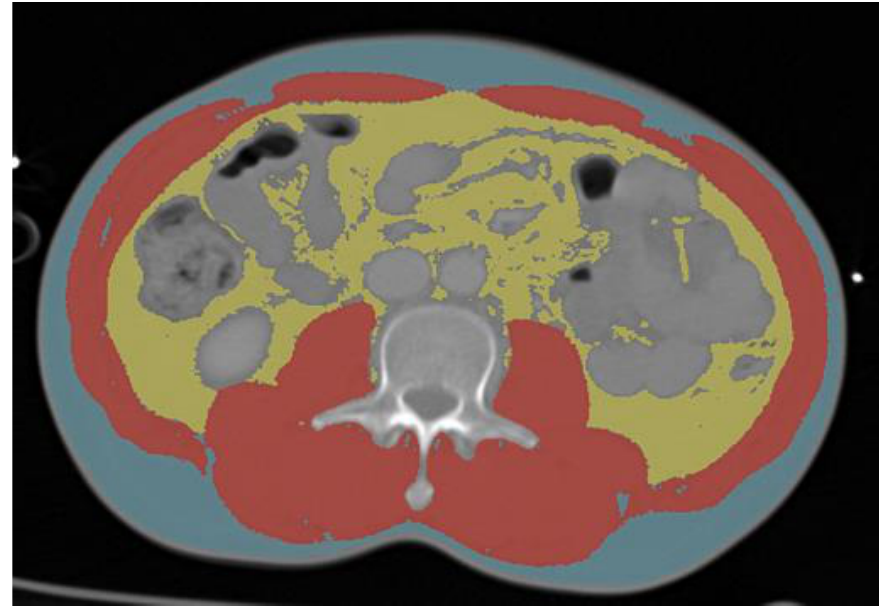
Figure 1. Segmentation at L3. Yellow: L3 visceral adipose tissue; red: L3 skeletal muscle tissue; blue: L3 subcutaneous adipose tissue